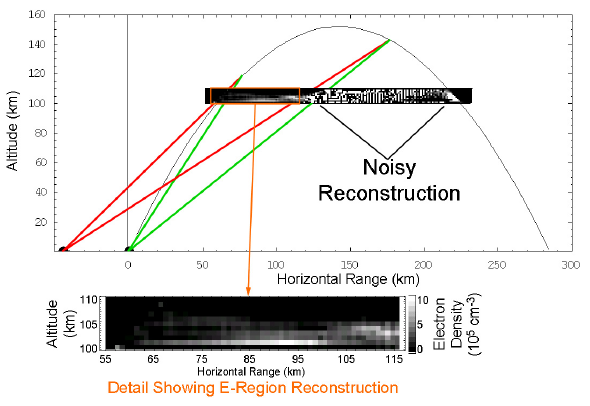
Fig. 17. SVD reconstruction of the DBB data during the flight of the SEEK-2-31 rocket using two ground Receivers, 1082 Samples Per Receiver (0.2s time samples or 158m horizontal range samples) and a reconstruction grid with 1km (H) × 1km (V) cell